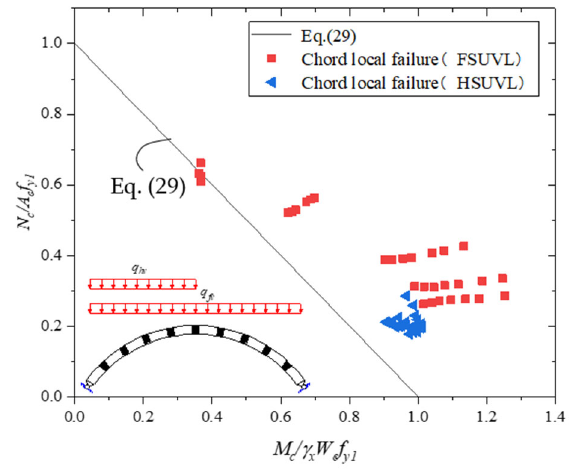
Figure 29. Comparison of Equation (29) with FE results.